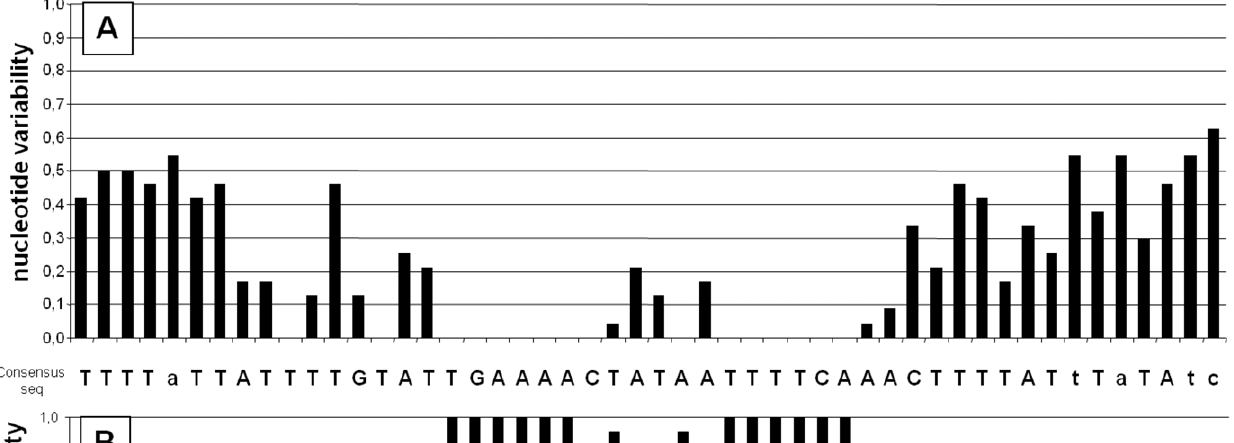
(Figure 6C), as did a derivative of this D xerH strain complemented by a highly expressed intact xerH gene (Figure 6C). These outcomes suggest that XerH levels are regulated – that either too much or too little can be deleterious.